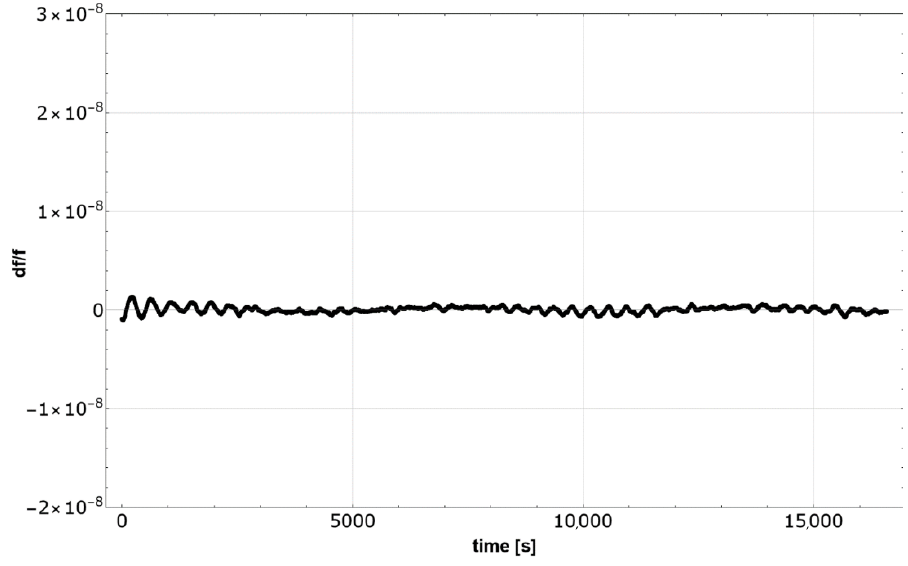
Figure 7. The simulation results of frequency accuracy in synchronized state, PMU-B.